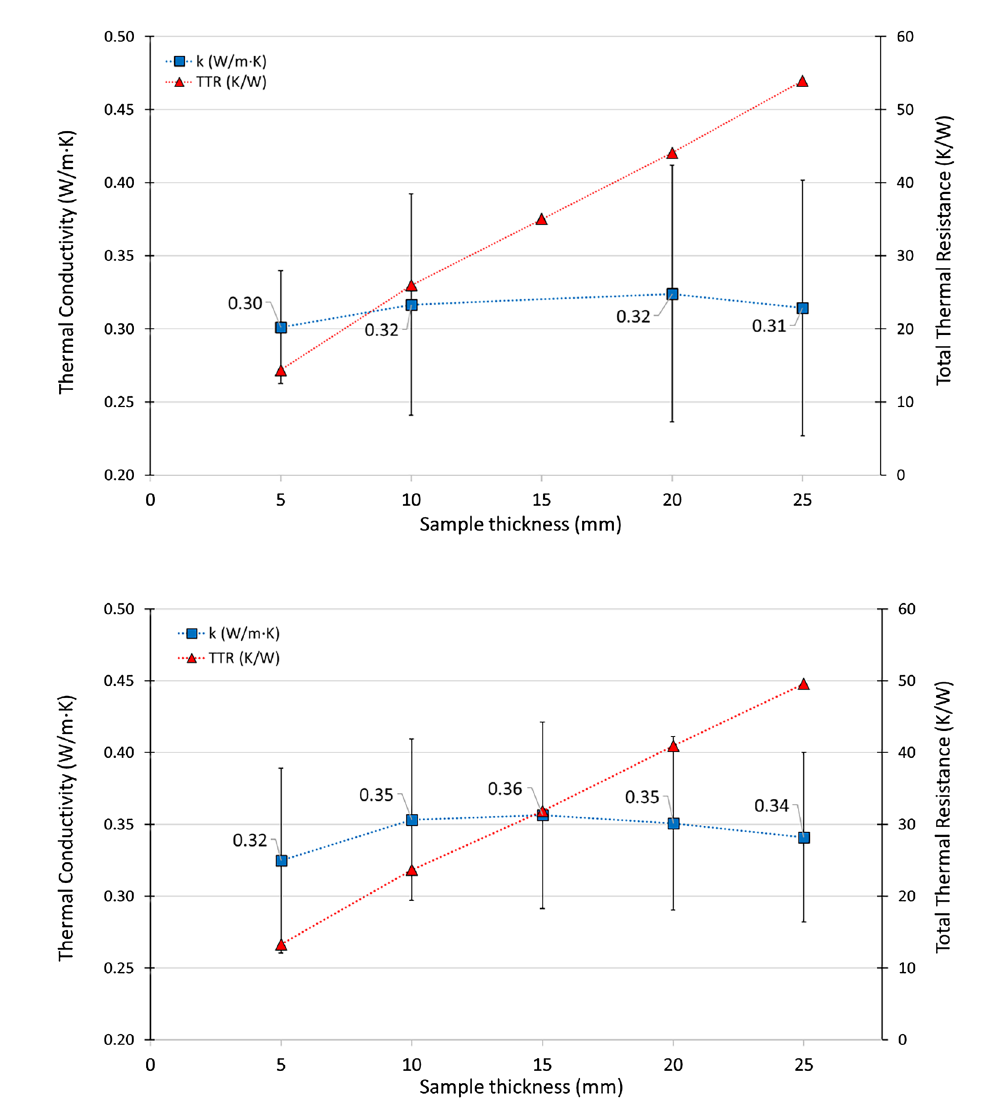
Fig. 6 Study result. Resin Type 1- HIGH TEMP [sample contact